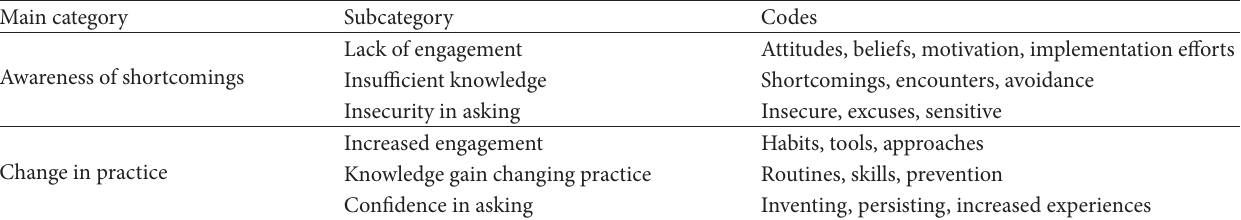
Table 3: Overview of the main categories and subcategories regarding change in staff’s experiences of SBI work during an implementation